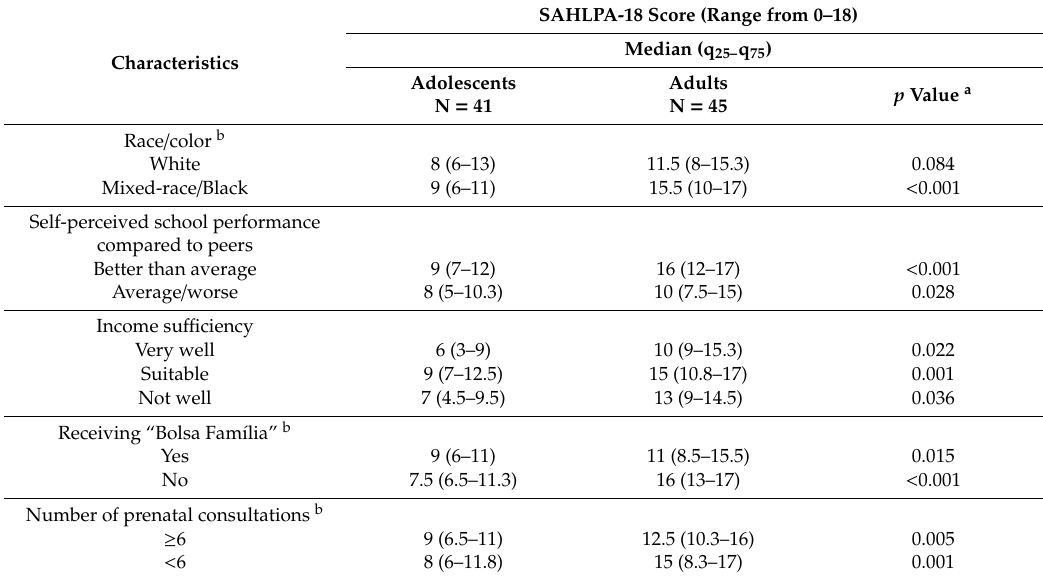
Table A1. Comparison of SAHLPA scores among adolescents and adults for each category of the independent variables (N =